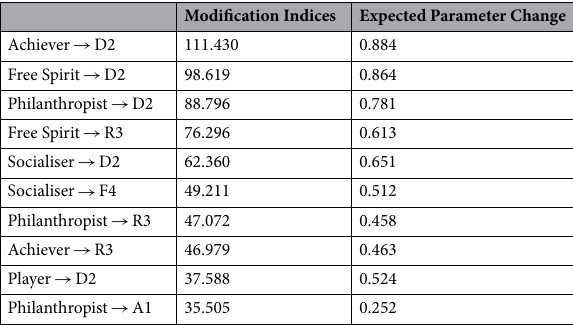
Table 2. Modification indices of the first CFA. N = 421.